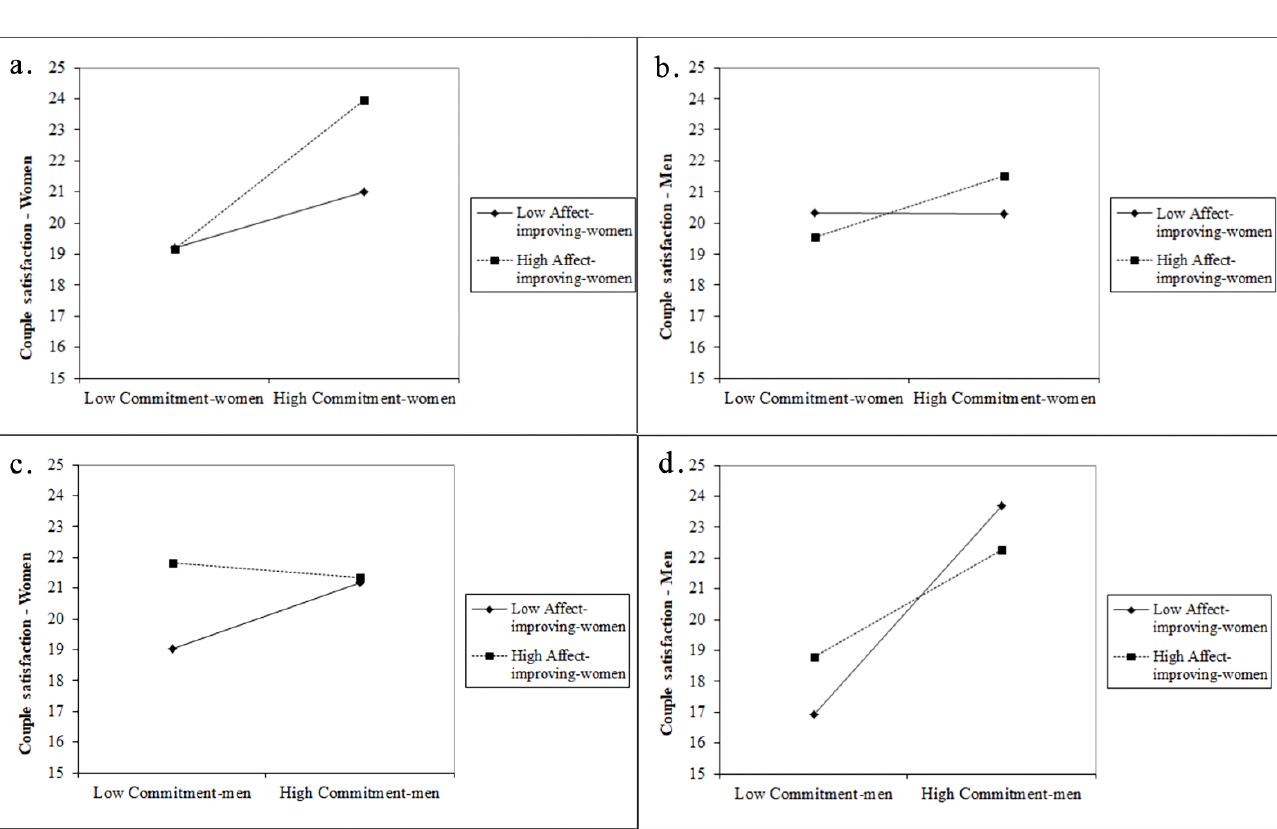
Figure 2. Women’s and men’s couple satisfaction with women’s or men’s low and high commitment for women that use less vs. more interpersonal affect-improving strategies: ( a ) women’s satisfaction with their commitment and use of interpersonal affect-improving strategies; ( b ) men’s satisfaction with women’s commitment and use of interpersonal affect-improving strategies; ( c ) women’s satisfaction with men’s commitment and women’s use of interpersonal affect-improving strategies; ( d ) men’s satisfaction with their commitment and women’s use of interpersonal affect-improving strategies.